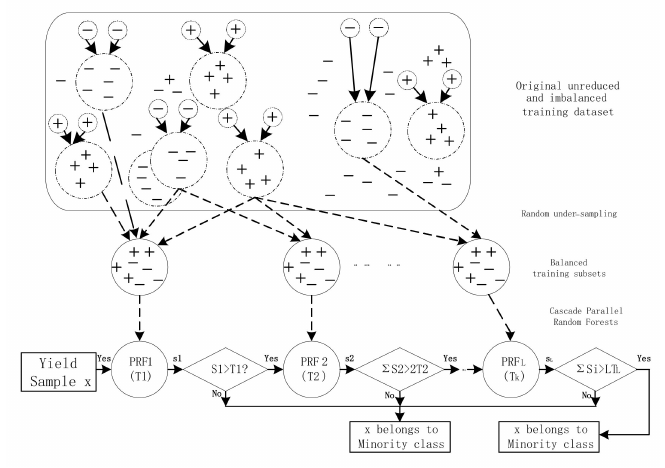
Figure 1. Architecture of